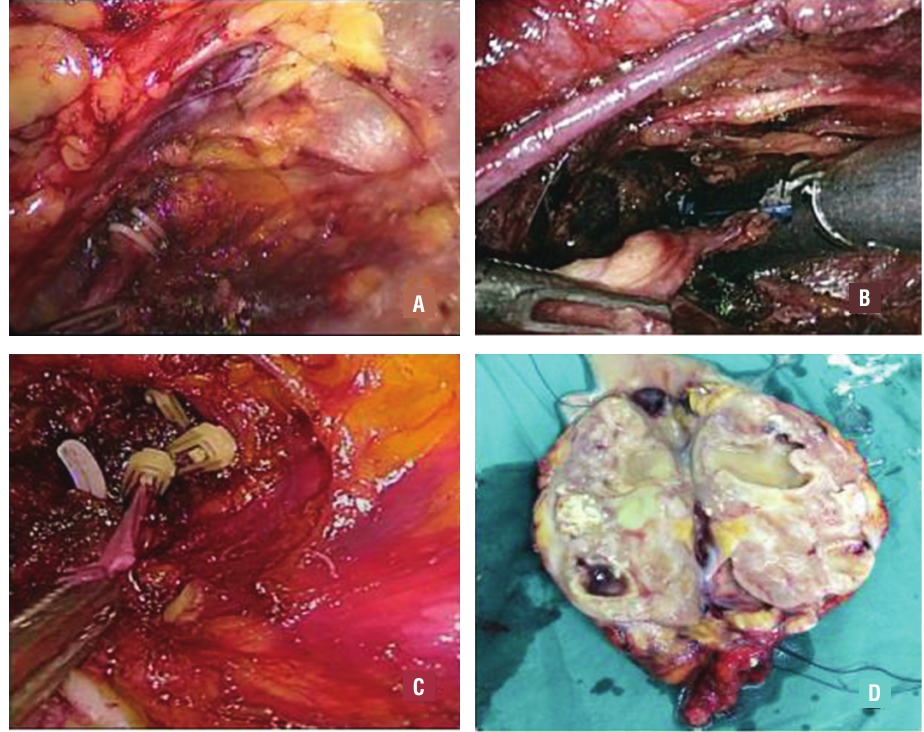
Figure 2 - The different methods of mutilation of the distal